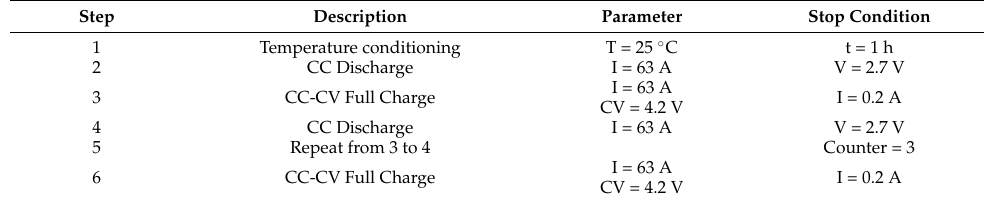
Table 4. Capacity test procedure.